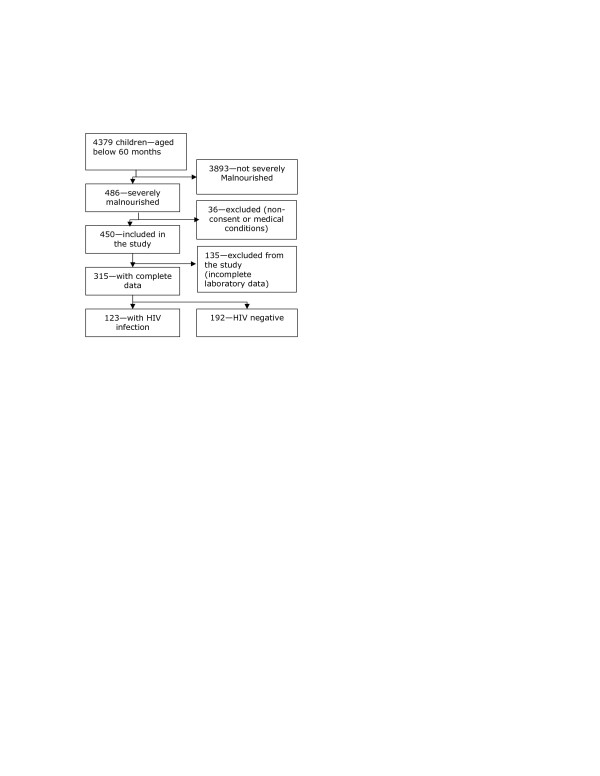
Study profile showing the enrolment process of the 315 children in the study.